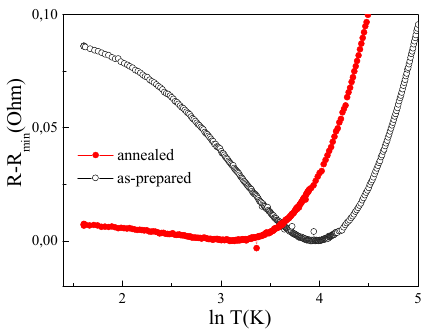
Figure 25. R-R min ( ln T) dependence for as-prepared and annealed at 400 °C Cu 90 Co 10 microwires.